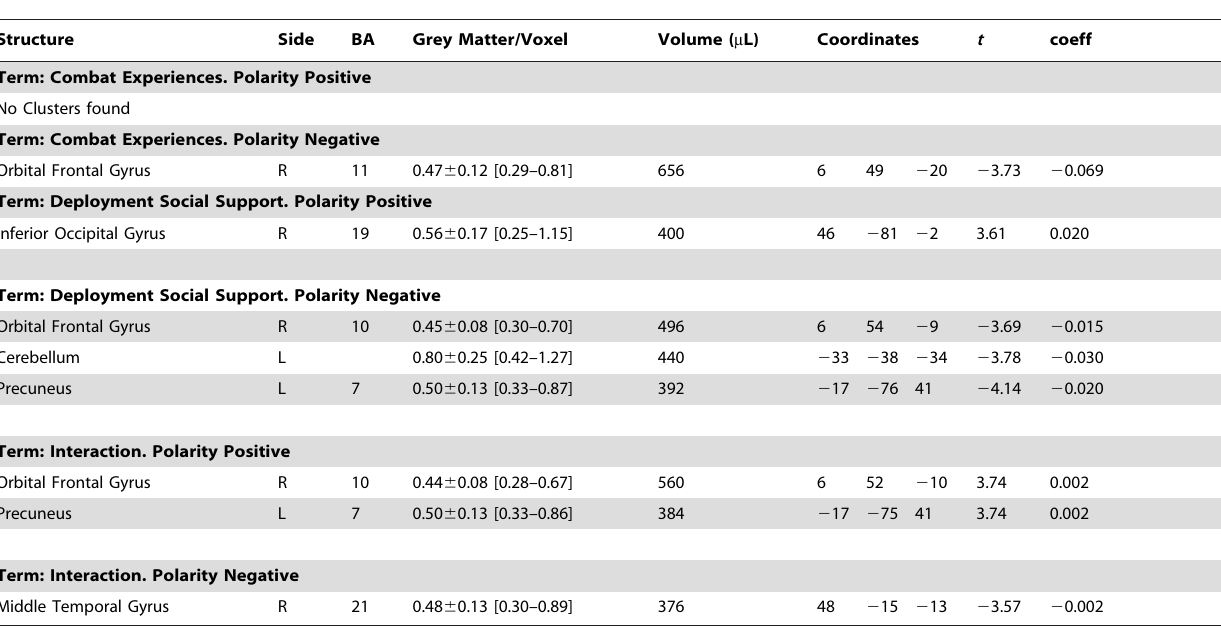
Table 2. Results from regression analyses investigating relationship between deployment experiences and gray matter volume.